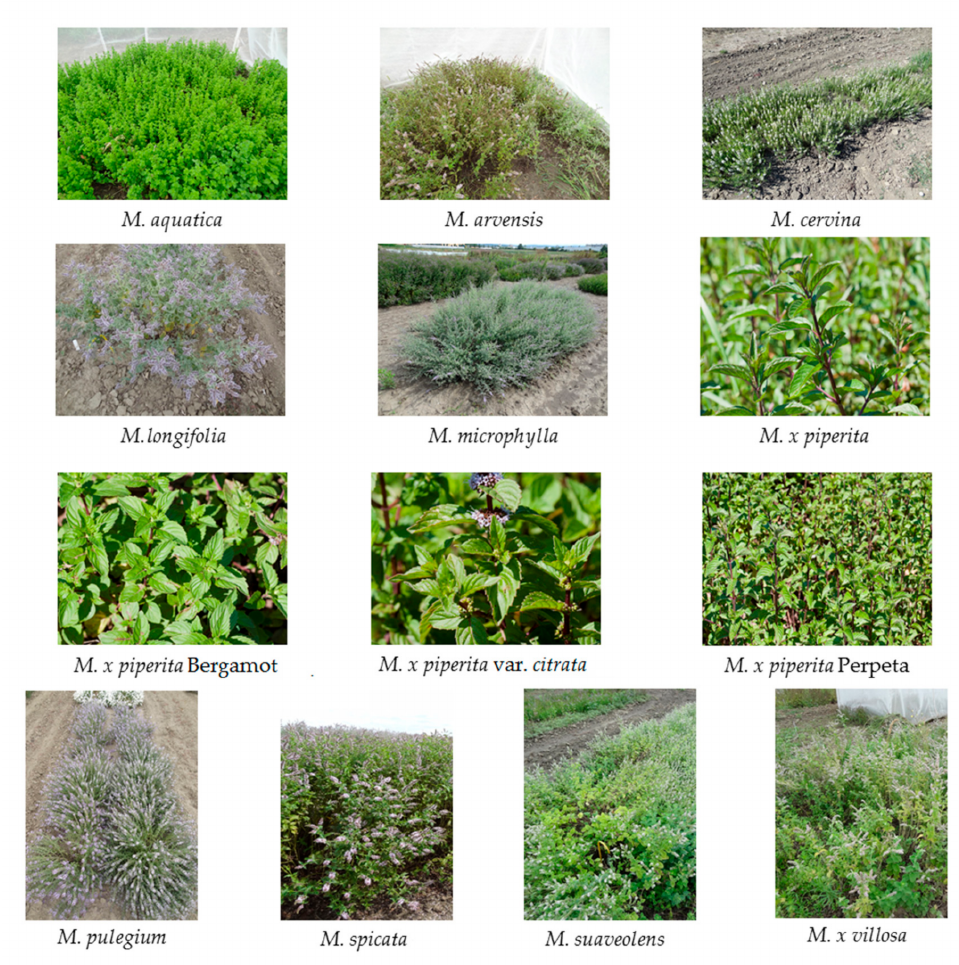
Figure 6. Mentha sp. used in the